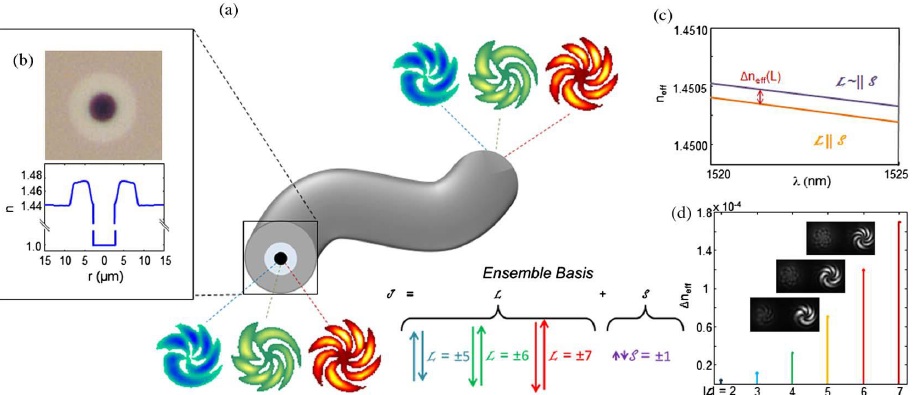
Figure 6. ( a ) Schematic picture of OAM mode transmission through a randomly bended and twisted AH-RCF conserving their original states. Each state has a total angular momentum J that consists of orbital component L and spin part s . ( b ) Cross section image (top) and measured refractive index profile (bottom) for the AH-RCF. ( c ) Example of n eff separation between near-degenerate OAM modes. ( d ) The splitting of n eff for near-degenerate OAM modes among different OAM mode groups and the modal interference images when | L | = 5, 6 and 7. Reprinted with permission from Ref. [35] © The Optical